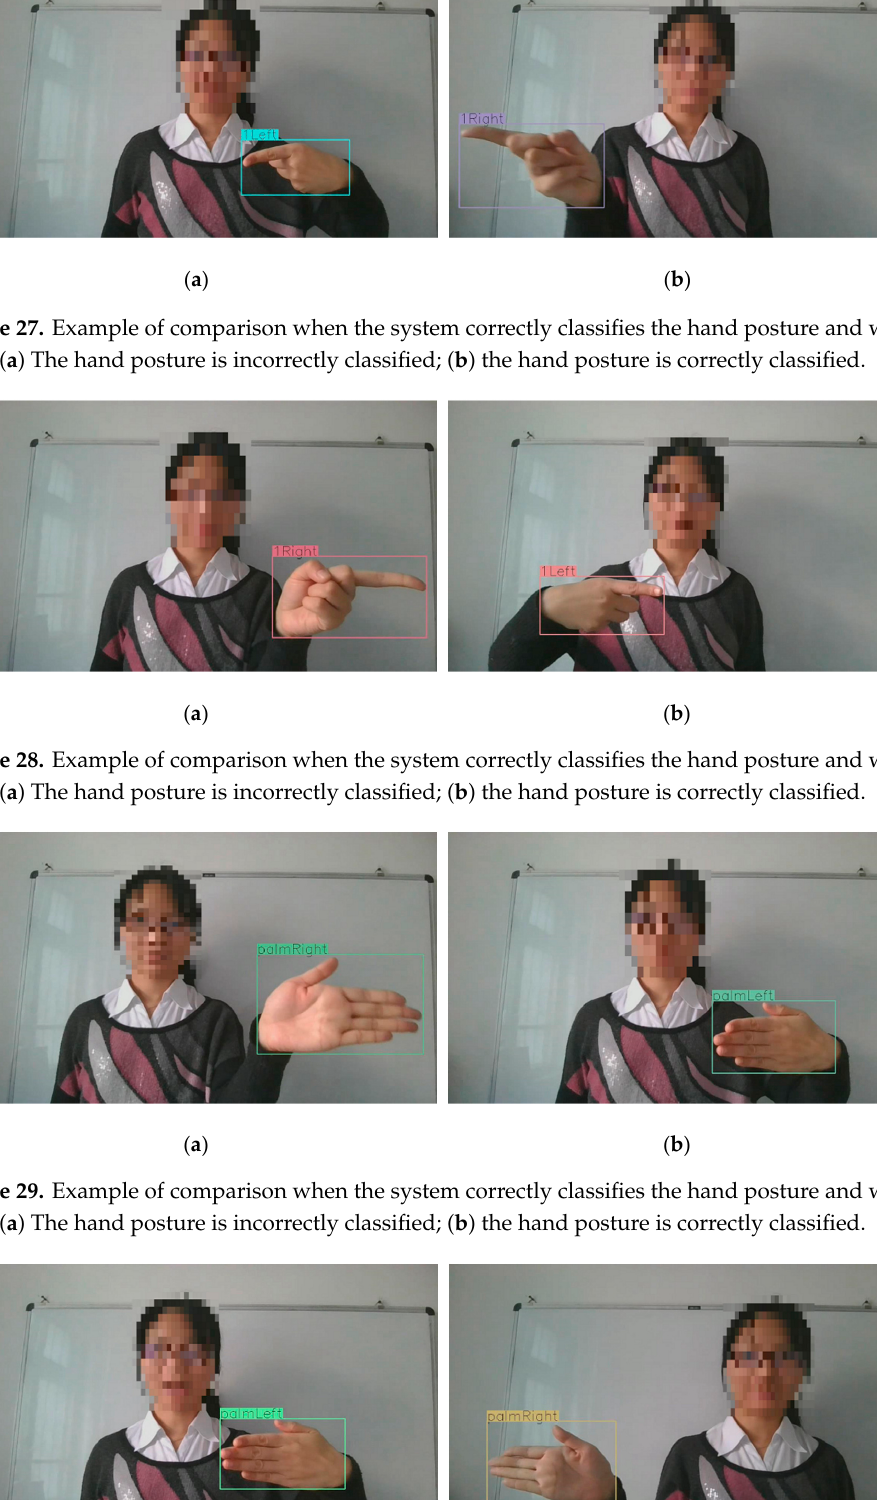
Figure 26. Results of the integration of deictic hand posture and spoken instructions.